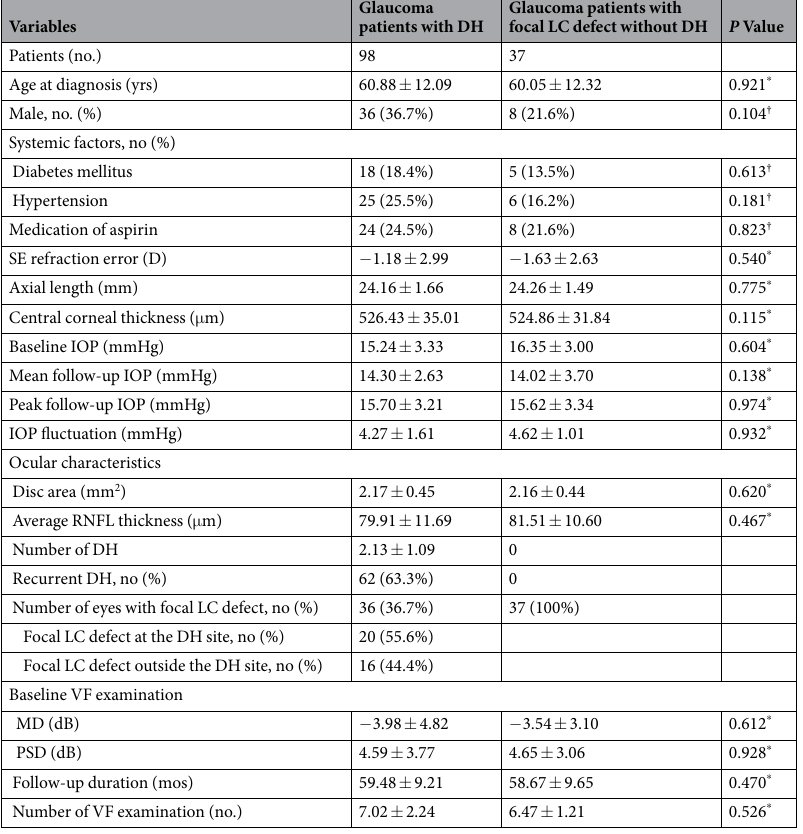
hazard model are shown in Table 3. Baseline IOP (HR, 1.076; 95% CI, 0.899–1.170; P = 0.098) and the presence of a focal LC defect at the DH site (HR, 2.620; 95% CI, 1.421–4.831; P = 0.002) were each found to be associated with VF progression ( P < 0.10) in univariate analyses. Multivariate analyses also showed that a focal LC defect at the DH site (HR, 2.502; 95% CI, 1.265–4.948; P = 0.008) was significantly related to VF progression in OAG patients with DH (Table 4). Further analyses were performed by comparing DH eyes with a focal LC defect at the DH site (n = 20), DH eyes with a focal LC defect outside the DH site (n = 16), DH eyes without a focal LC defect (n = 62), and eyes with focal LC defect without DH (n = 37). Among them, 14 (70.0%) DH eyes with a focal LC defect at the DH site, 6 (37.5%) DH eyes with a focal LC defect outside the DH site, 25 (40.3%) DH eyes without a focal LC defect, and 16 (43.2%) eyes with focal LC defect without DH showed VF progression; statistical significance were found between focal LC defect at the DH site and DH without focal LC defect ( P = 0.009), between focal LC defect at DH site and focal LC defect without DH ( P = 0.050), and between focal LC defect at the DH site and the rest groups ( P = 0.033). The estimated slope for the MD was − 0.96 ± 0.72 dB/year in DH eyes with a focal LC defect at